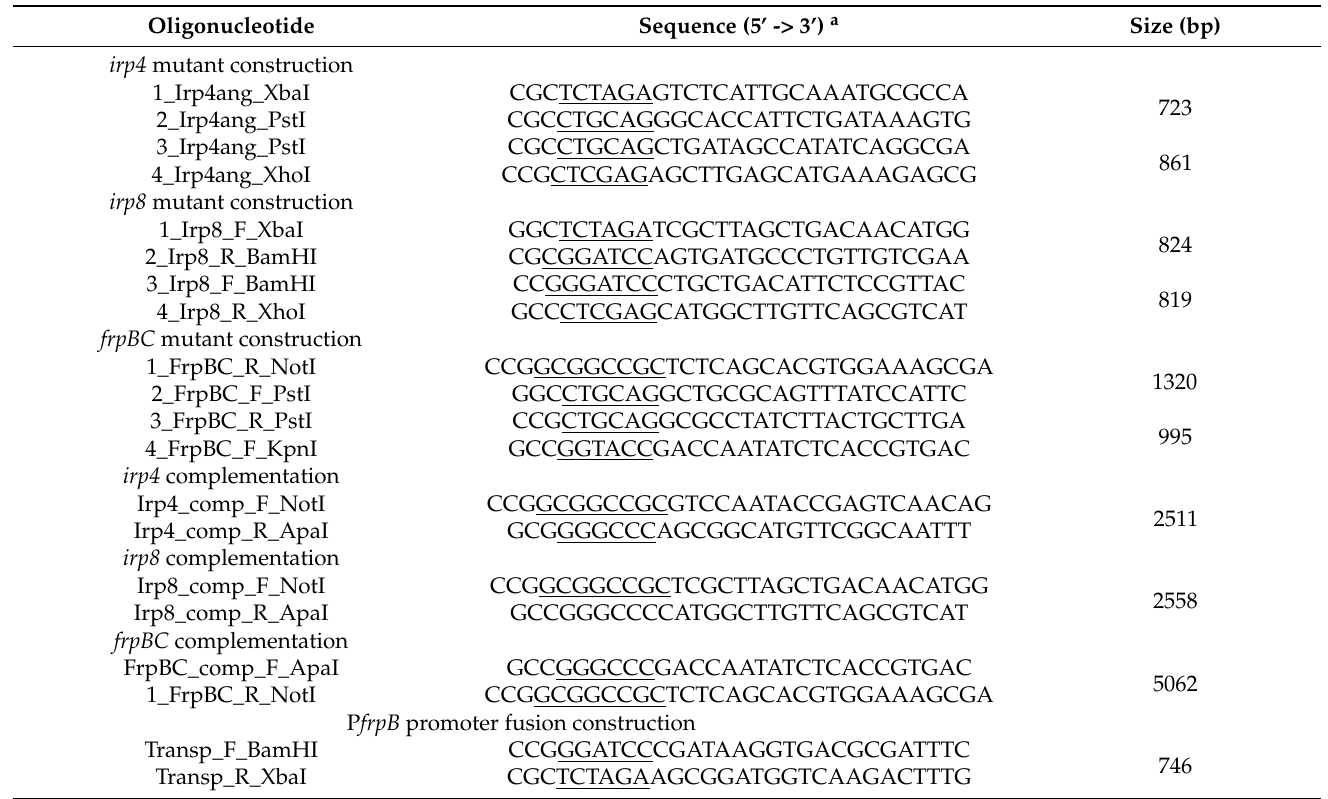
Table 2. The primers used in this